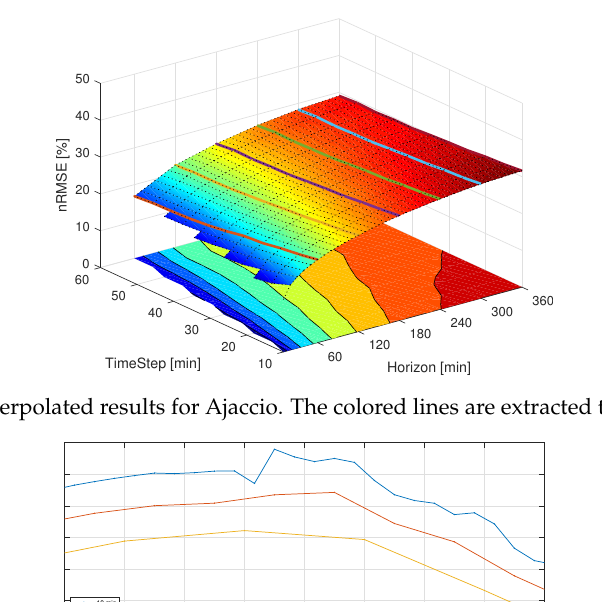
Figure 7. Error of ARMA models for the different time-steps and horizons in Ajaccio and Odeillo.